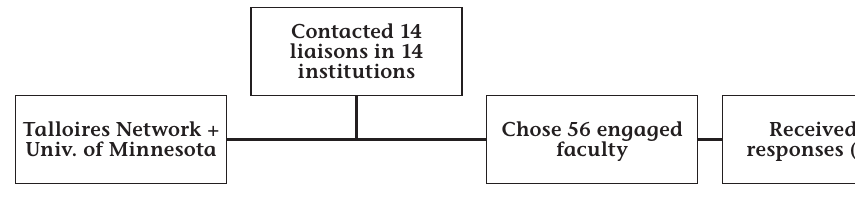
Figure 1. Survey Distribution and